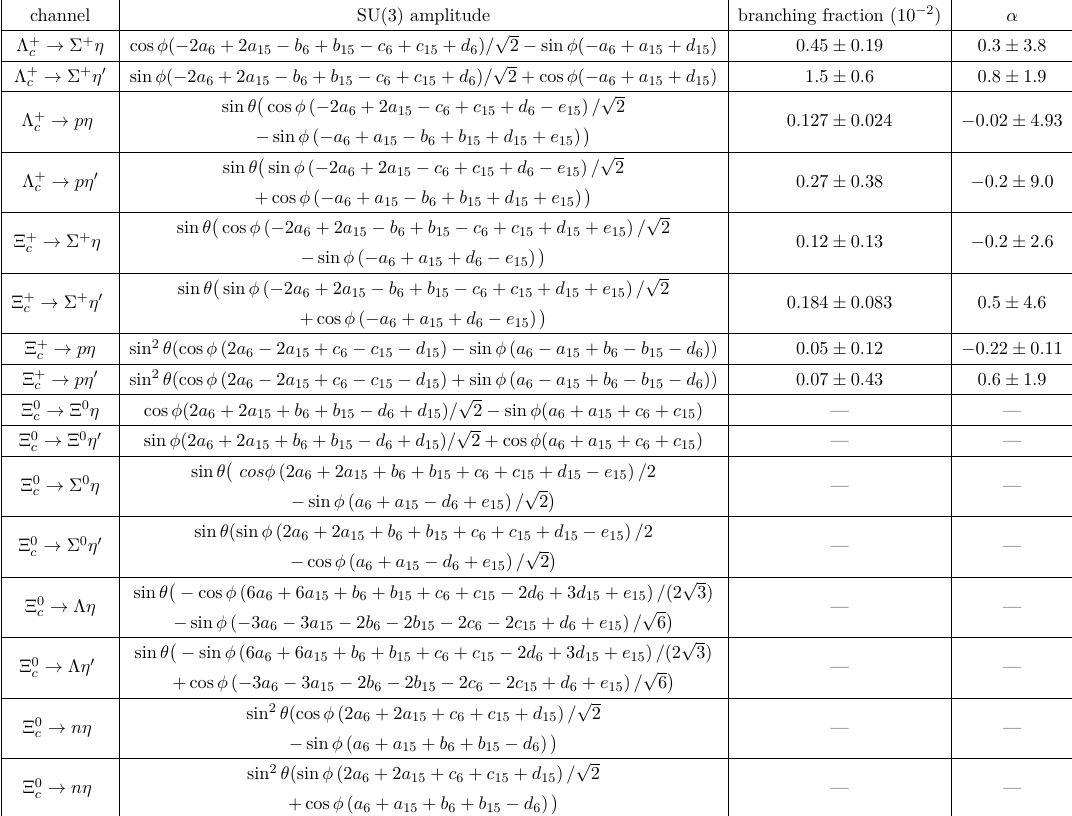
Table 2 . SU(3) amplitudes and predicted branching fractions (the third column) and polarization parameters (the fourth column) of anti-triplet charmed baryons decays into an octet baryon and η or η 0 . In this table “—” represent the channel can not be prediction due to the limit of experimen- tal